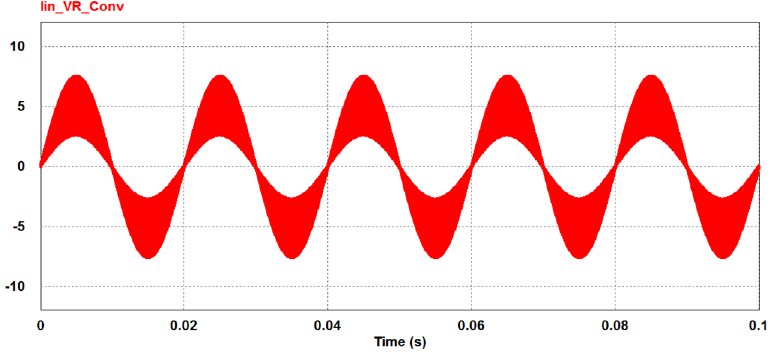
Figure 15. Input current waveform of an IH system with a conventional VR.